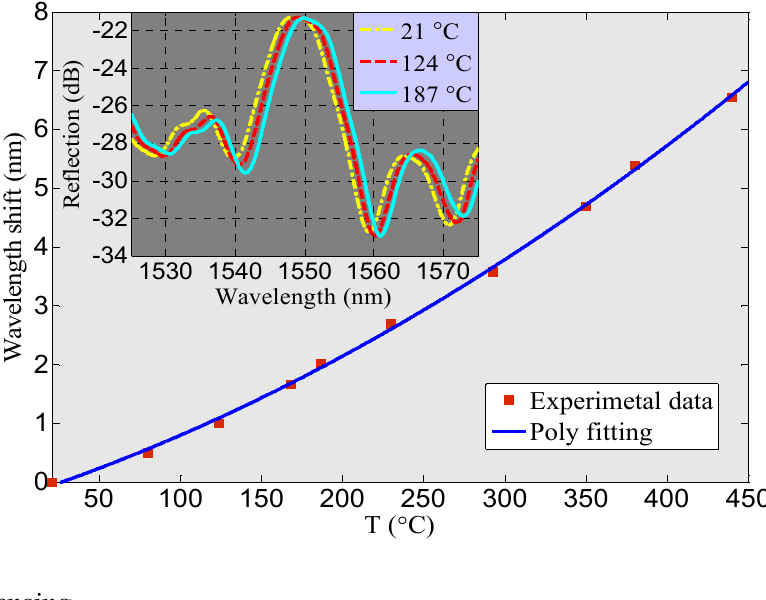
Figure 8. Dependence of the measured wavelength shift on temperature T. Inset: reflection spectra of the MFBG in air at three different